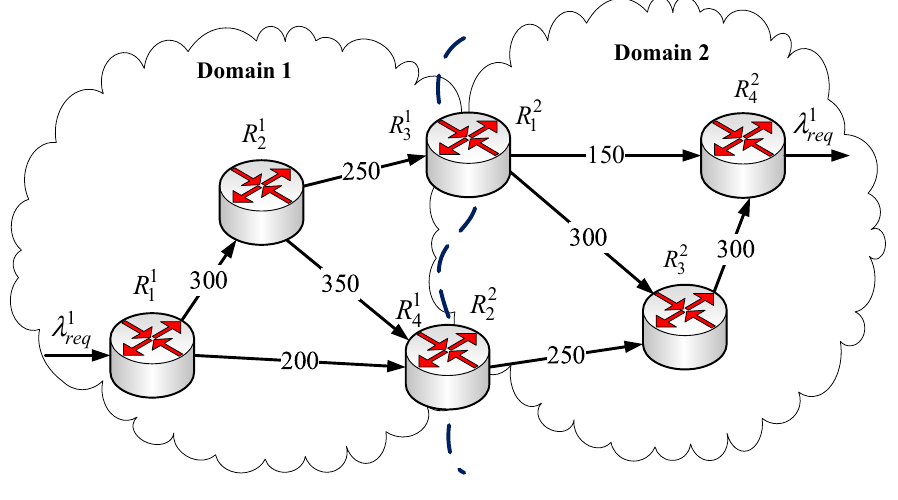
Figure 2. Network structure under investigation.